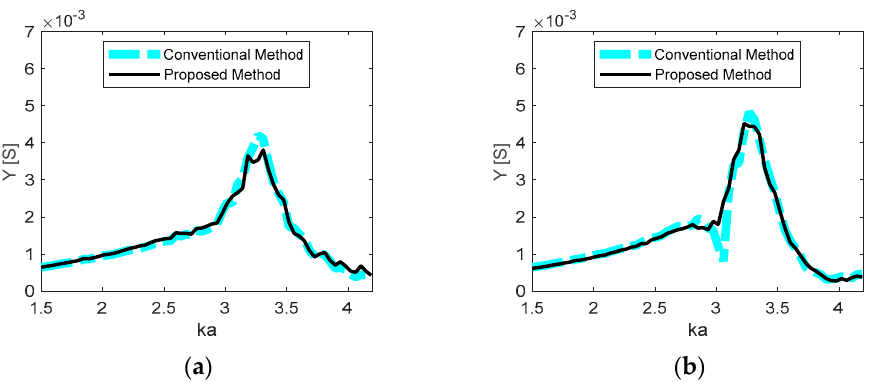
Figure 8. Electrical admittance of transducer #7 calculated by the proposed method (solid line) and the conventional FEM (thick dashed line) when ( a ) θ = 0 ◦ and ( b ) θ = 30 ◦ .